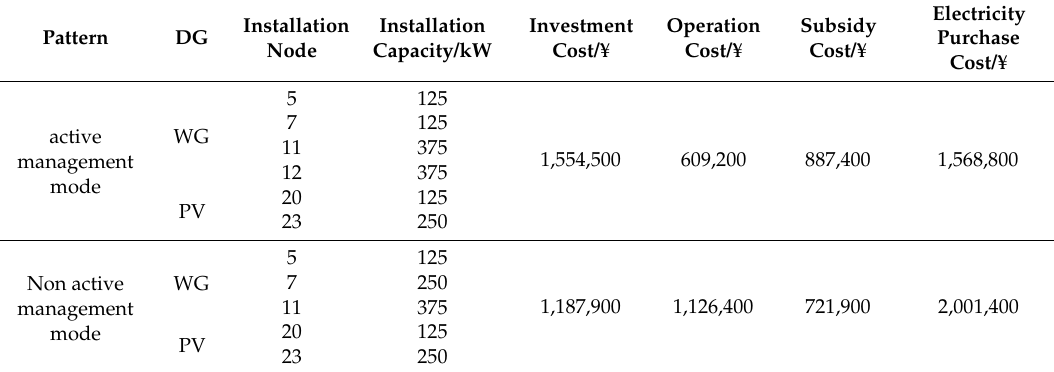
Table 2. Optimal allocation schemes with and without active management. WG: Wind generator Pattern